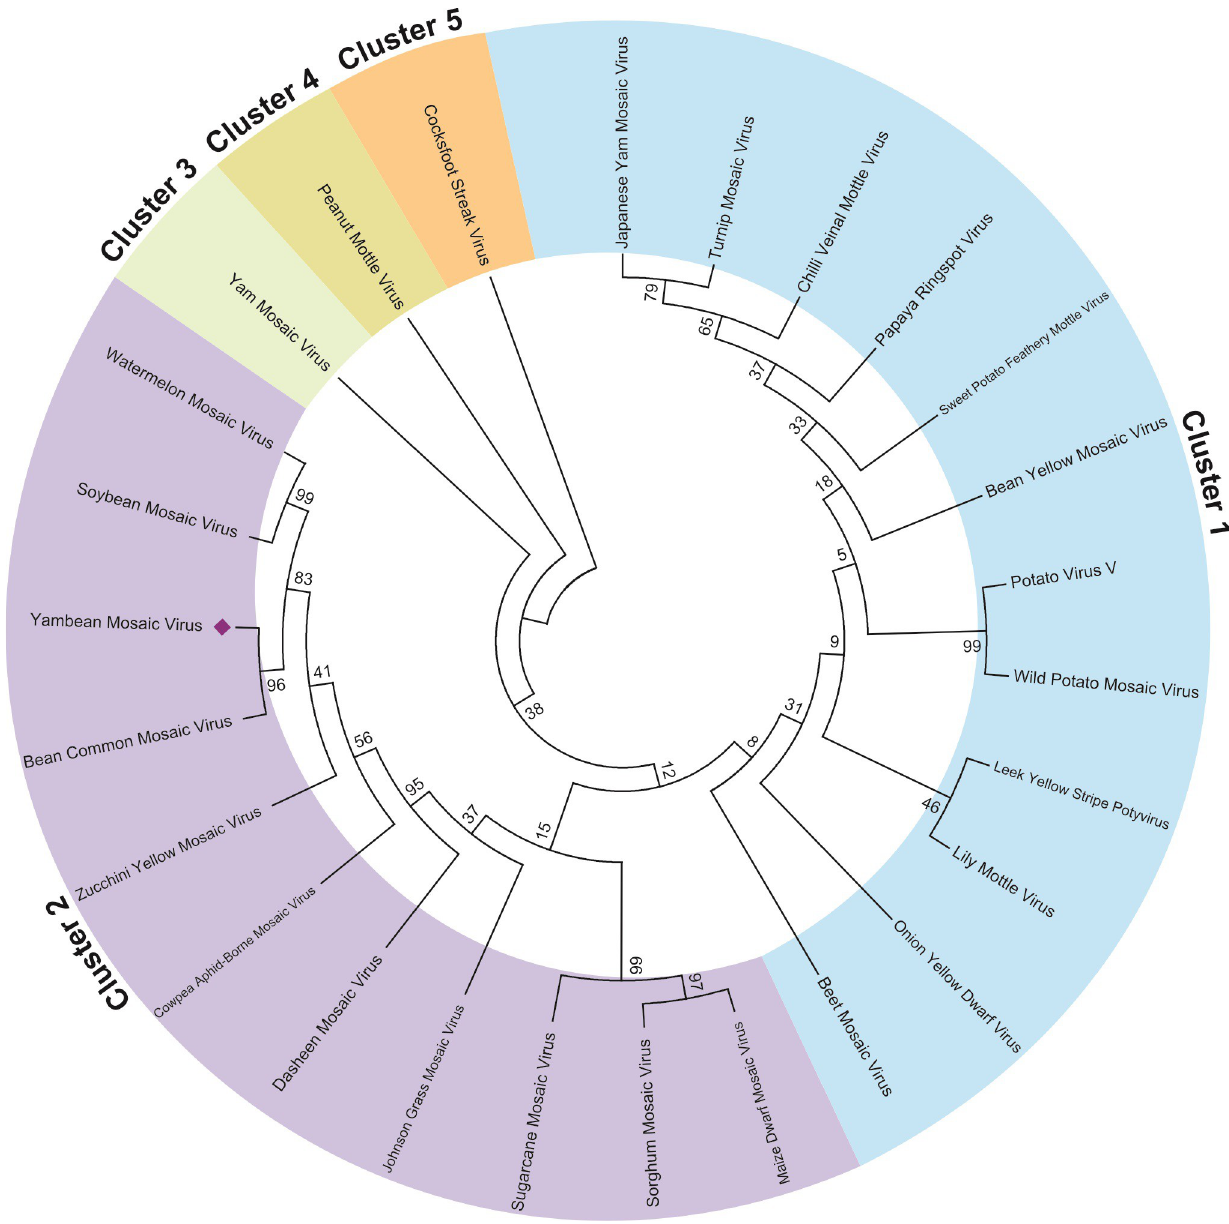
Fig 1. The evolutionary relationship of taxa of YBMV CP and other closely related organisms using the NJ method. The bootstrap test (1000 repetitions) showed the percentage of replicate trees where the related taxa were grouped. The analysis was conducted using MEGA version 6.0